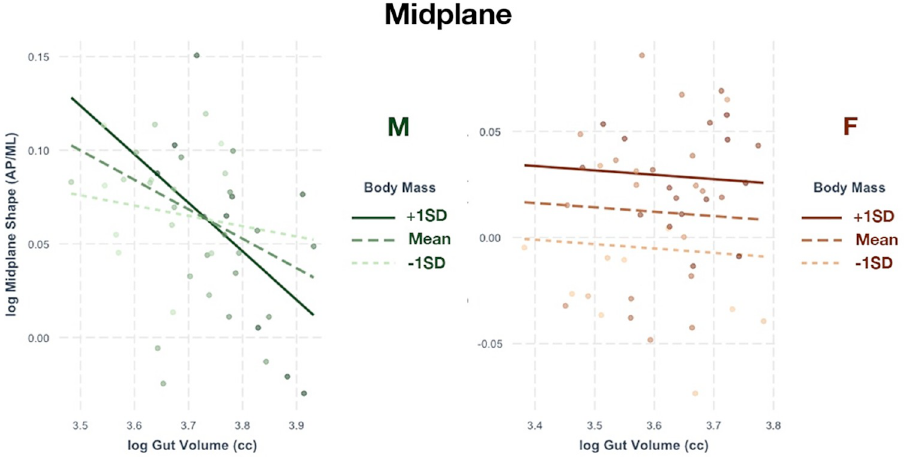
Fig 4. Relationship of midplane shape with gut volume. Regressions between gut volume and pelvic canal shape at the midplane relative to body mass. Both the male and female samples (right, orange) show significance.